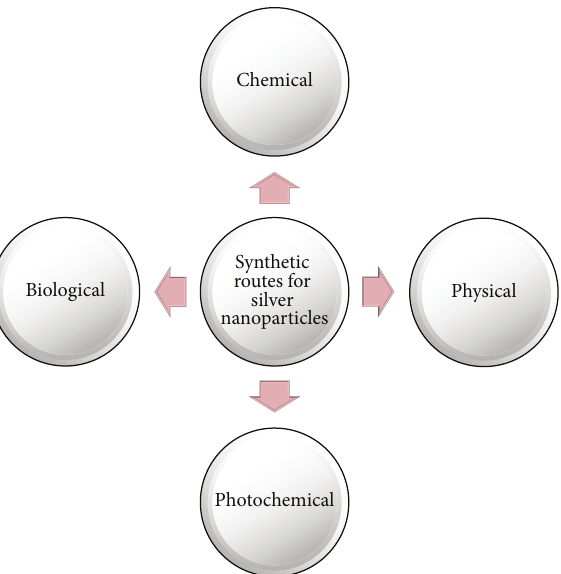
Figure 2: Various synthetic routes adopted for the synthesis of Ag- NPs with uniform